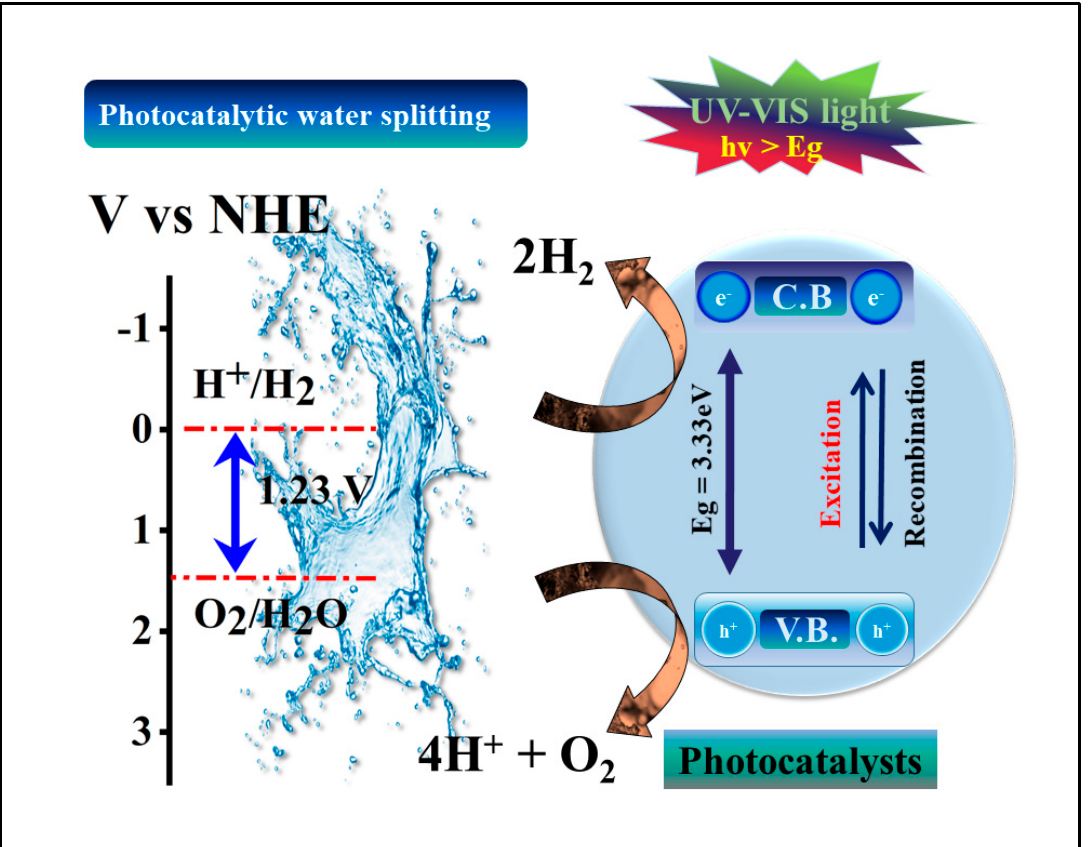
Figure 10. Schematic mechanism of the photocatalytic water splitting for H 2 evolution.